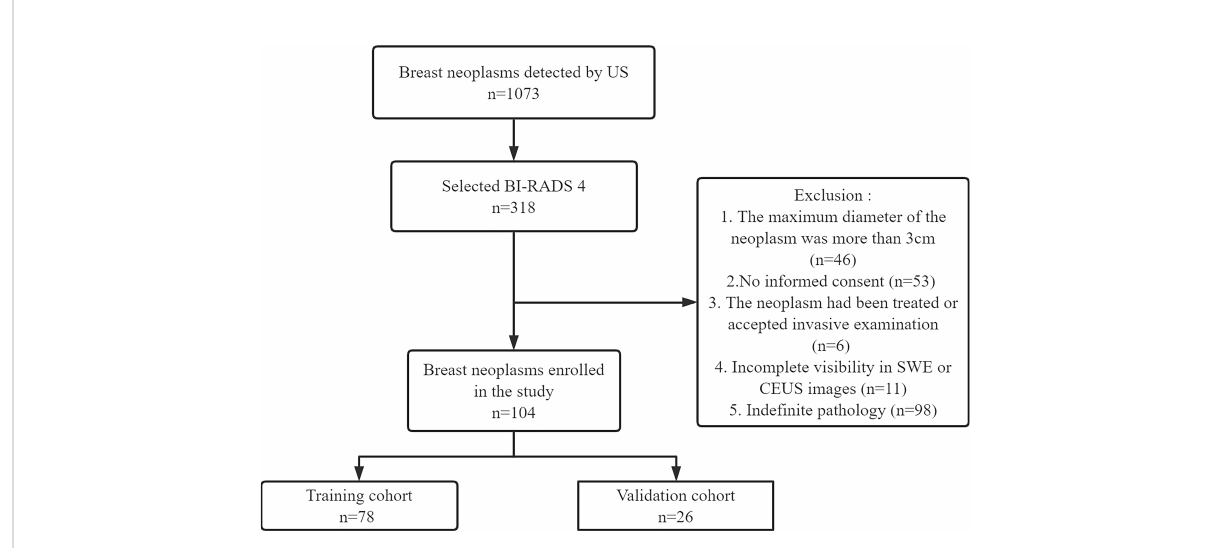
FIGURE 1 The fl owchart of this